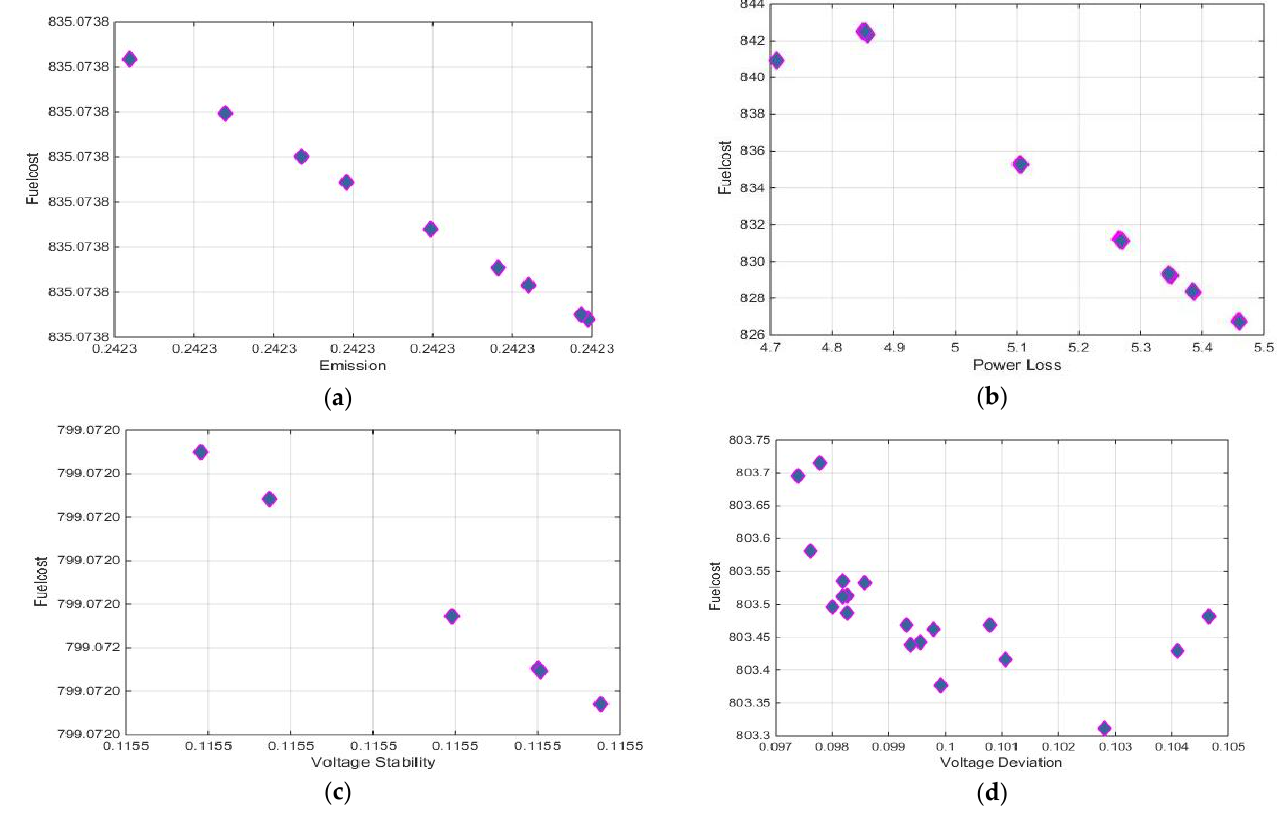
Figure 2. Bi-objective Pareto set of OPF in Cases 6 – 9. ( a ) Case 6; ( b ) Case 7; ( c ) Case 8; ( d ) Case 9. Table 6. TFWO versus recent optimization algorithms for tri-objective functions (IEEE-30 bus test system) Cases